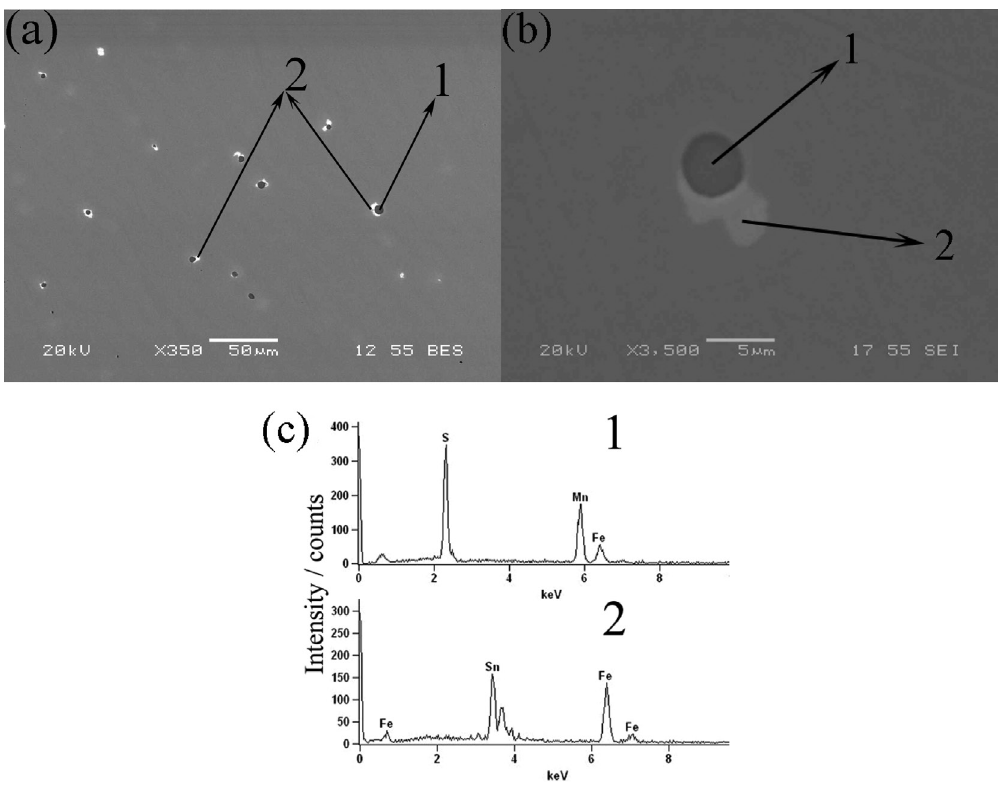
Fig. 1: SEM morphology (a), enlarged image (b), and chemical composition (c) of the precipitates in